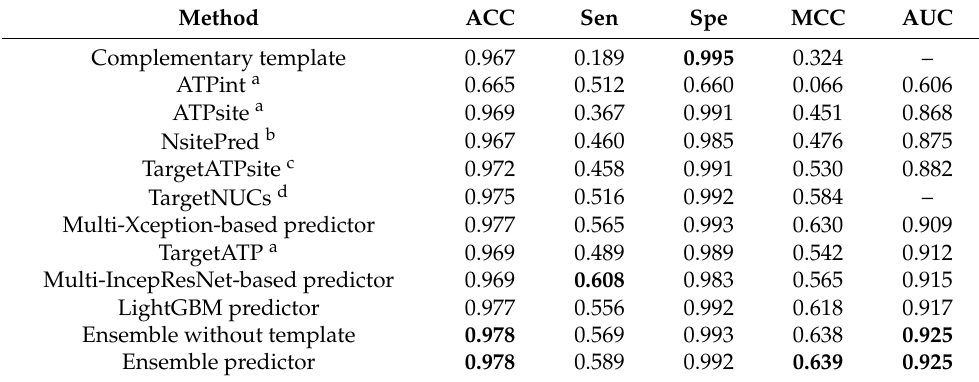
Table 1. Performance comparison between our proposed method and other sequence-based methods on ATP-17 testing set (methods are ranked according to AUC and the highest value of each column in the table is shown in